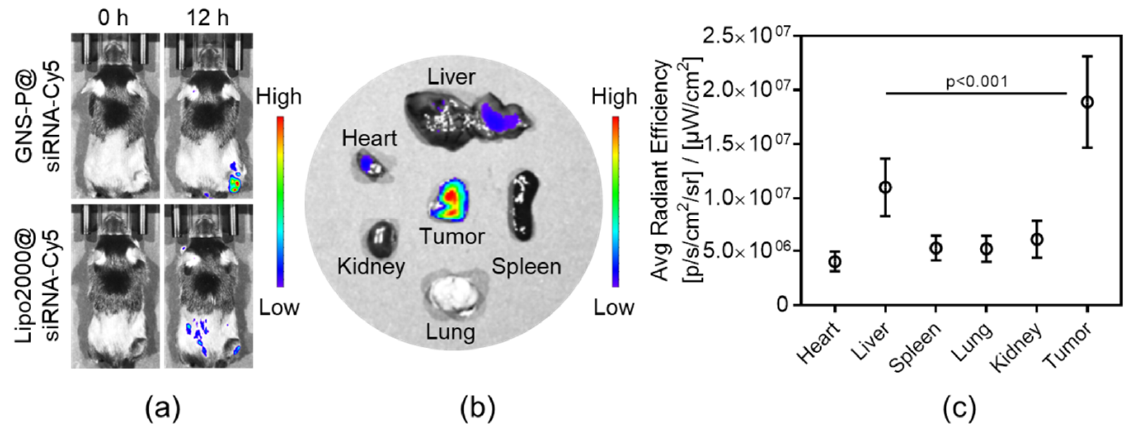
Figure 10. ( a ) The expression of Bcl-2 in Panc02 cells after incubation with different siRNA delivery platforms by western blotting analysis. ( b ) Quantitative analysis of Bcl-2 expression by western blotting analysis in Panc02 cells after incubation with different siRNA delivery platforms. ( c ) Quantitative analysis of Bcl-2 expression by ELISA in Panc02 cells after incubated with different siRNA delivery platforms. Significance between every two groups was calculated using one-way ANOVA. Data are mean ± S.D.